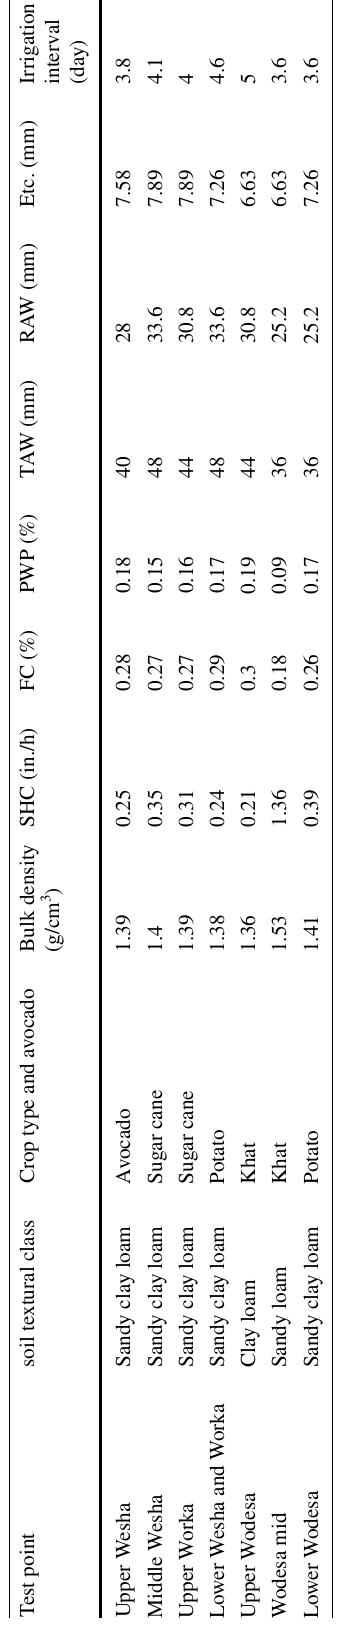
Table 8 Irrigation water application and infiltration rate on irrigation